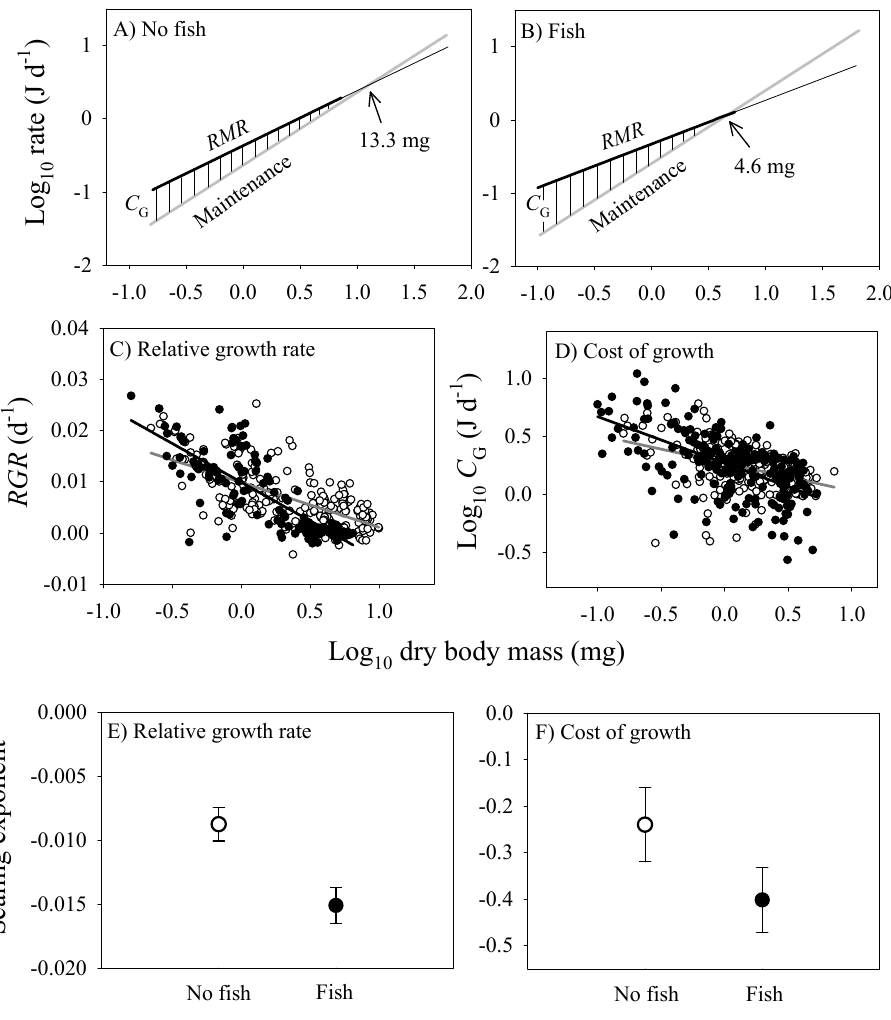
Figure 8. Scaling of log 10 relative growth rate and log 10 energy cost of growth with log 10 dry body mass in the amphipod Gammarus minus . The scaling relationships were calculated from data for each of two pairs of populations inhabiting springs without ( A , C , E ) versus with ( B , D , F ) fish predators. In ( A , B ) the scaling of the cost of growth ( C G ) is shown as the hatched area between the scaling relationship for resting metabolic rate ( RMR = black line) (taken from Figure 6) and that for maintenance energy expenditure ( C M ) (gray line) (taken from Figure 7). The dry body mass at which these scaling relationships converge, and at which growth was estimated to stop based on actual measurements, is also shown in each panel. The thin black lines represent extrapolations of the RMR scaling relationships beyond the body-mass ranges sampled. In ( C ), the scaling relationships between relative growth rate ( RGR ) and dry body mass are shown for amphipods from springs with (black line and black circles for individual points) versus without fish predators (gray line and open circles). The regression equations (including 95% confidence intervals for each parameter) are respectively Y = 0.00991 ( ± 0.00070) − 0.0151 ( ± 0.00140) X ( r = 0.849; N = 178; P < 0.00001) and Y = 0.00988 ( ± 0.00074) − 0.00877 ( ± 0.00131) X ( r = 0.660; N = 228; P < 0.00001). In D , the scaling relationships between C G and dry body mass are shown for amphipods from springs with versus without fish predators (indicated as in C ). The regression equations are respectively Y = 0.268 ( ± 0.0276) − 0.402 ( ± 0.0698) X ( r = 0.600; N = 230; P < 0.00001) and Y = 0.270 ( ± 0.0287) − 0.240 ( ± 0.0795) X ( r = 0.398; N = 190; P < 0.00001). In ( E , F ), the scaling exponents (slopes in the log-log plots shown in C and D ; ± 95% confidence intervals) for RGR and C G are compared between amphipods from springs with (black circles) versus without fish predators (open circles). Note that in both cases the scaling slope is significantly more negative for amphipods from the springs with versus without fish.